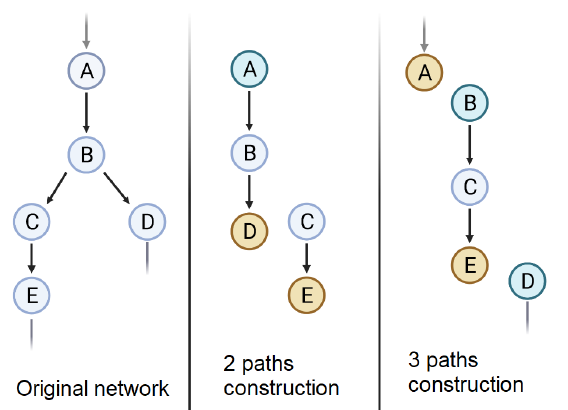
Figure 2. Two examples of metabolic pathways that can be constructed from a simple 5-node metabolic